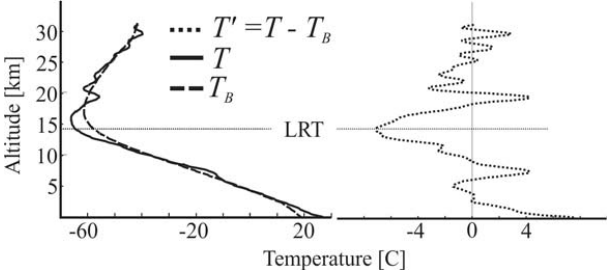
Fig. 1. A GPS RO temperature profile (solid), the background tem- perature determined by a filter (dashed) and their difference (dot- ted) on the right (Satellite CHAMP, lon=293.81 ◦ , lat= − 18.55 ◦ , 30 May 2001,